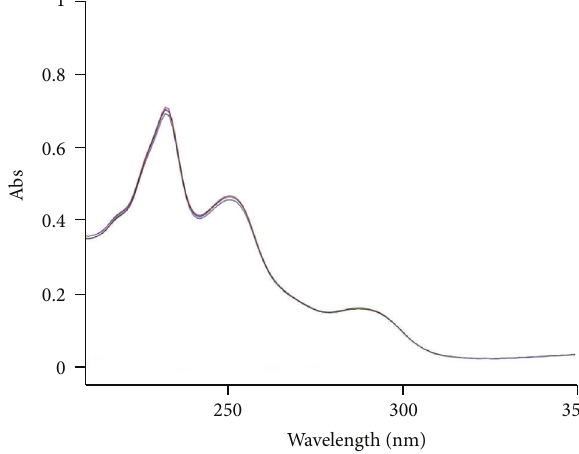
Figure 2: UV spectra of unirradiated and gamma irradiated daunorubicin.